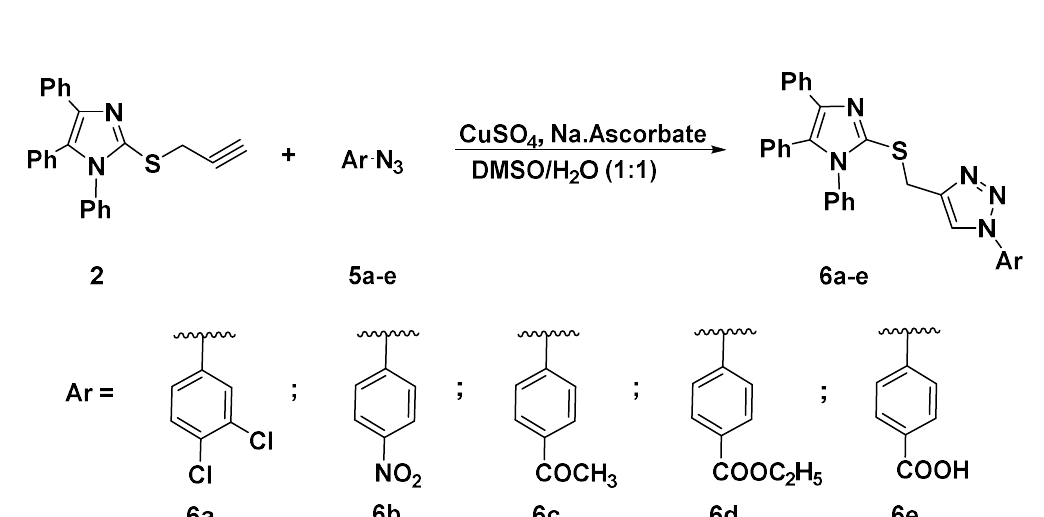
Table 1. Anticancer screening of the synthesized compounds expressed as IC 50 ( µ M) using the MTT assay. IC 50 values are expressed as the mean ± SD of three independent experiments. Compound